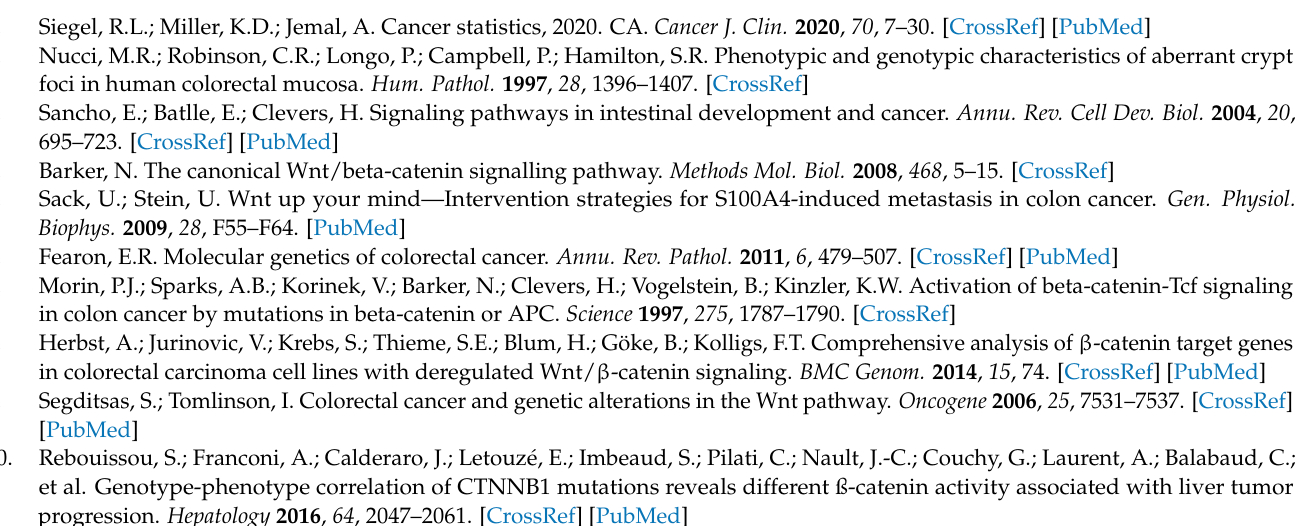
Figure A2. Induced ectopic expression of S100A4 in xenograft tumors results in a reduced abundance of human DKK1 in mouse plasma. ( a ) Schematic representation of the lentiviral vector for doxycycline-induced S100A4 expression. The respective control vector was generated without the coding sequence for S100A4 (not shown). Either vector was lentivirally transduced into HAB92 cells. ( b ) Plasma samples of mice intrasplenically transplanted with HAB92/tetON-S100A4 or HAB92/tetON-ctrl cells were taken after 15 days with or without doxycycline treatment. Immunostaining with human-specific DKK1 antibodies after WB showed reduced hDKK1 abundance in plasma samples of mice with induced S100A4 expression in the xenograft tumors.